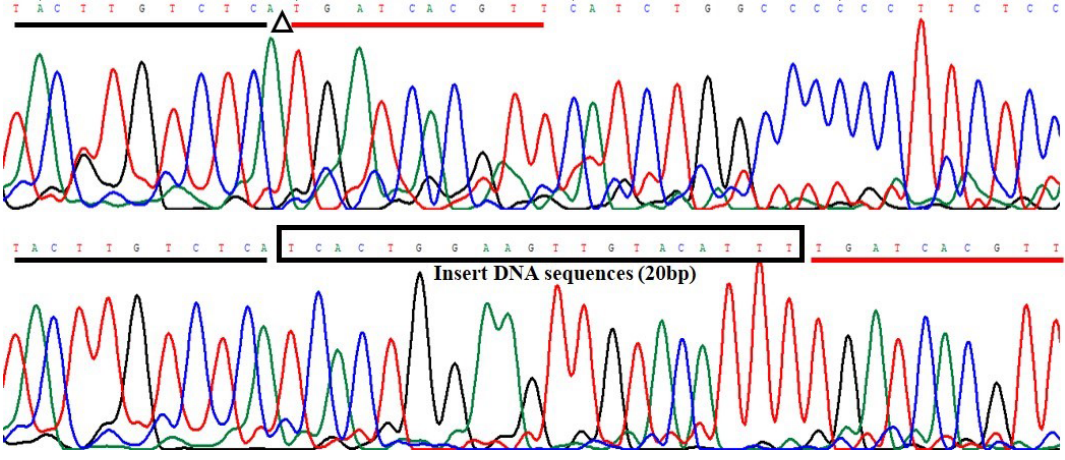
Figure 2. Sequencing maps of 20-bp indel in CDC25A goat gene. Table 3. Relationship between the 20-bp indel locus of CDC25A gene and growth-related traits in SBWC goat (least square mean, LSM a ±